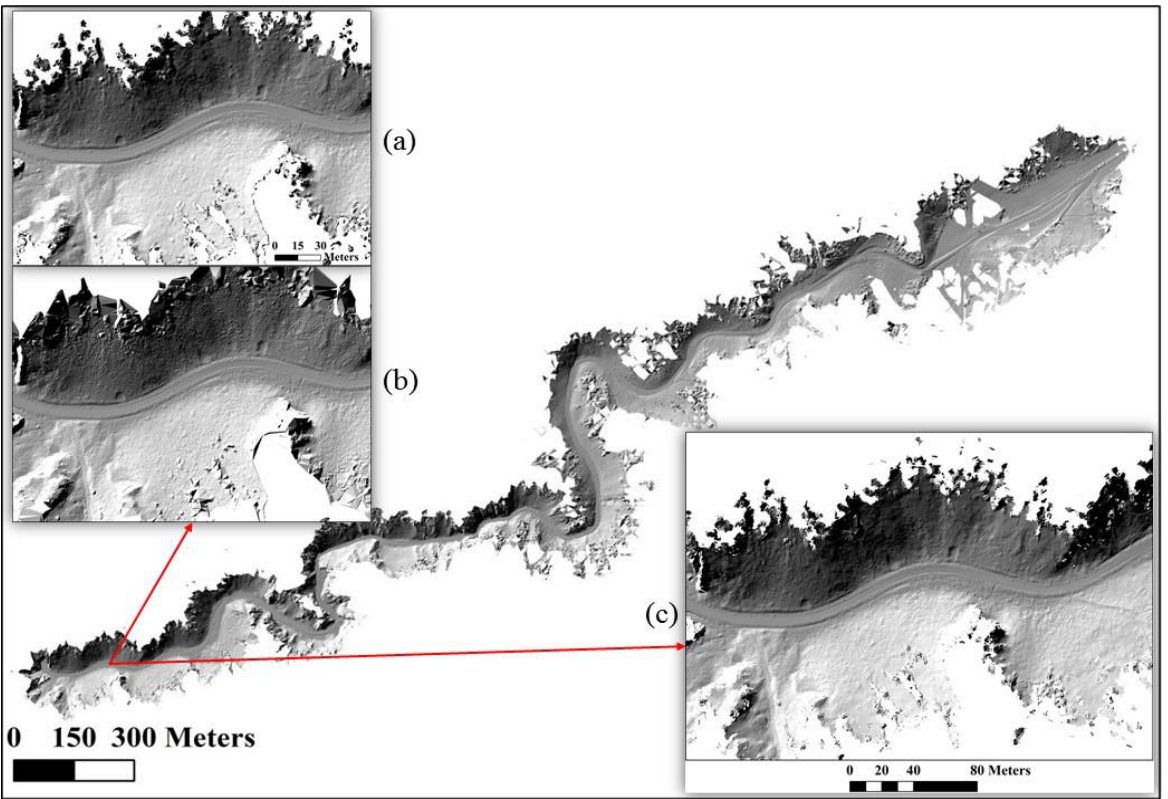
Figure 4. Shading of the DTM (grid size 0.25 x 0.25 m): main image – road 1 combination of robust moving planes and triangulation; (a) moving paraboloid; (b) triangulation; (c) robust moving